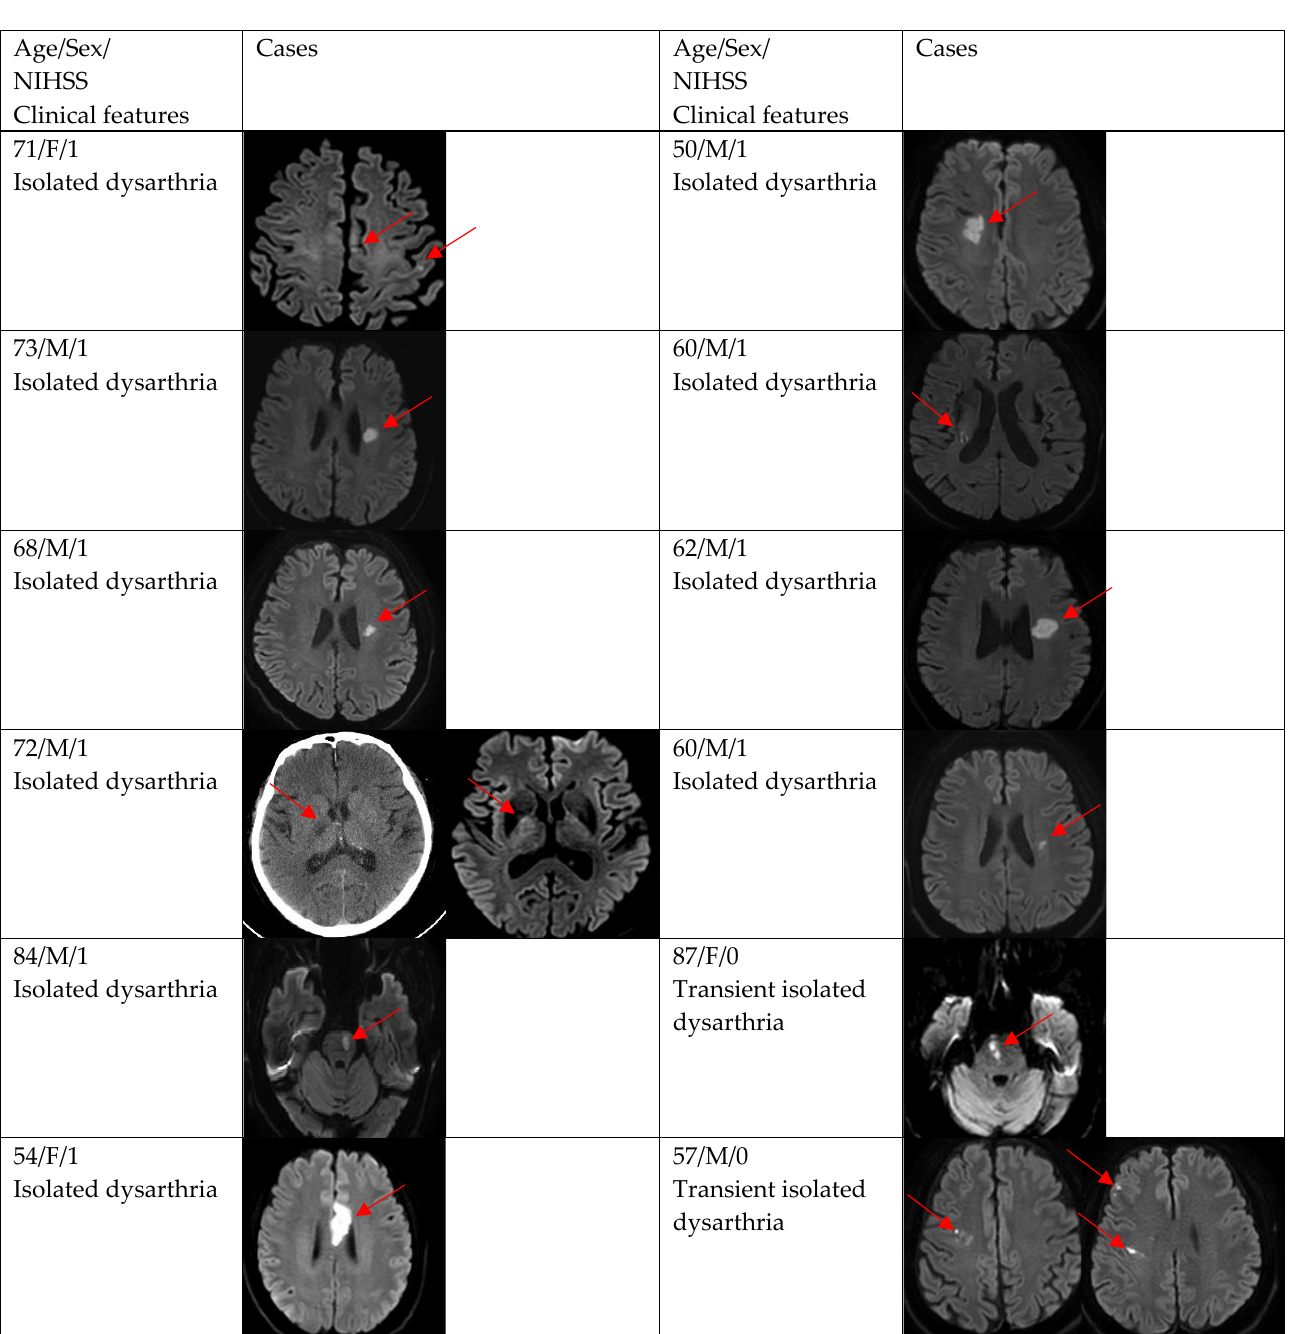
multiple or territorial lesions on DWI. In the prominent dysarthria group, 16 patients had small and single lesions, and 13 patients had